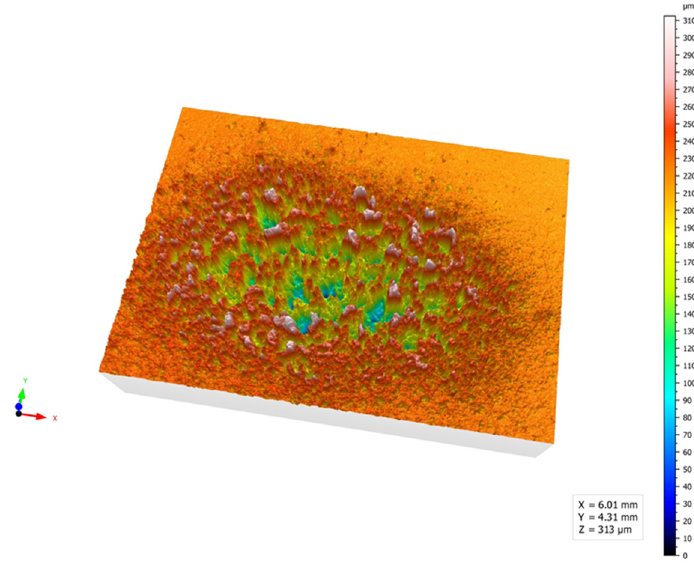
Figure 15. Three-dimensional image of surface